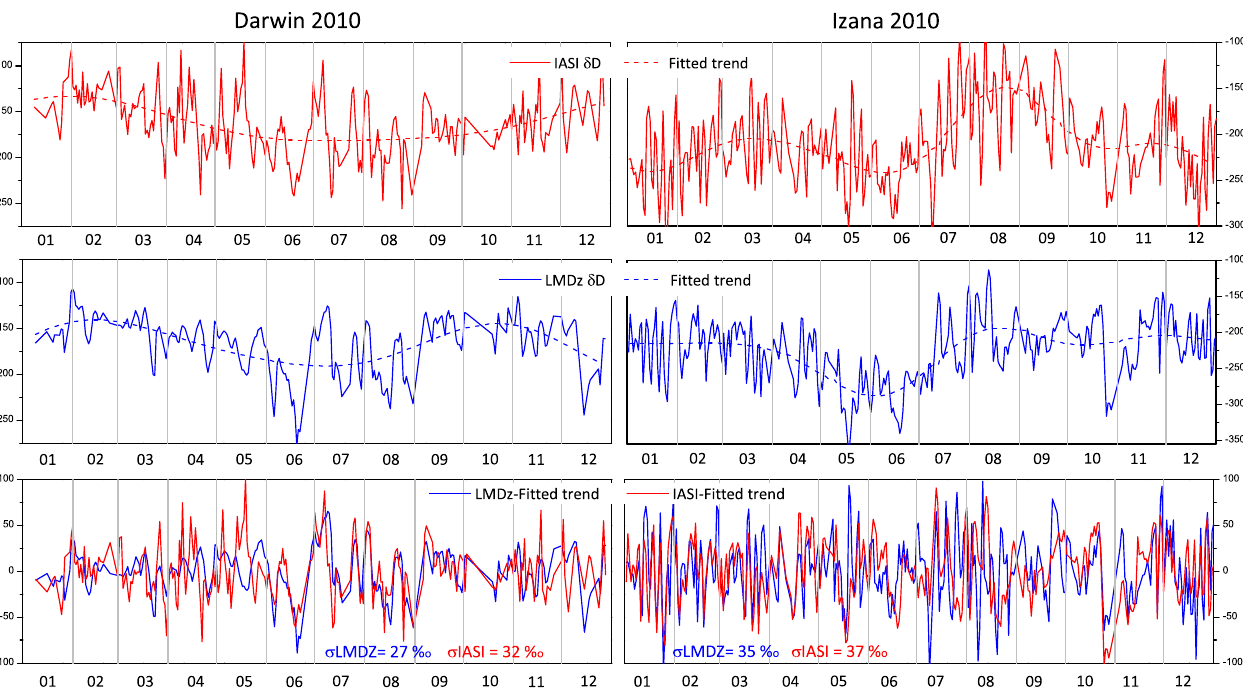
Fig. 9. δ D time series at Darwin and Iza˜na retrieved from IASI (top) and simulated by LMDz (middle). The dotted lines are fitted Fourier functions isolating the broad seasonal component of the variations. The bottom panels show the detrended time series obtained by subtracting the Fourier functions from the raw